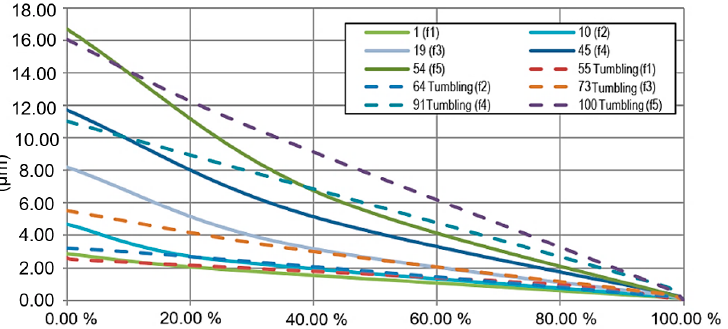
Figure 21. The bearing area curves of selected cylindrical samples (No. 1–54 without tumbling and No. 55–108 with tumbling).